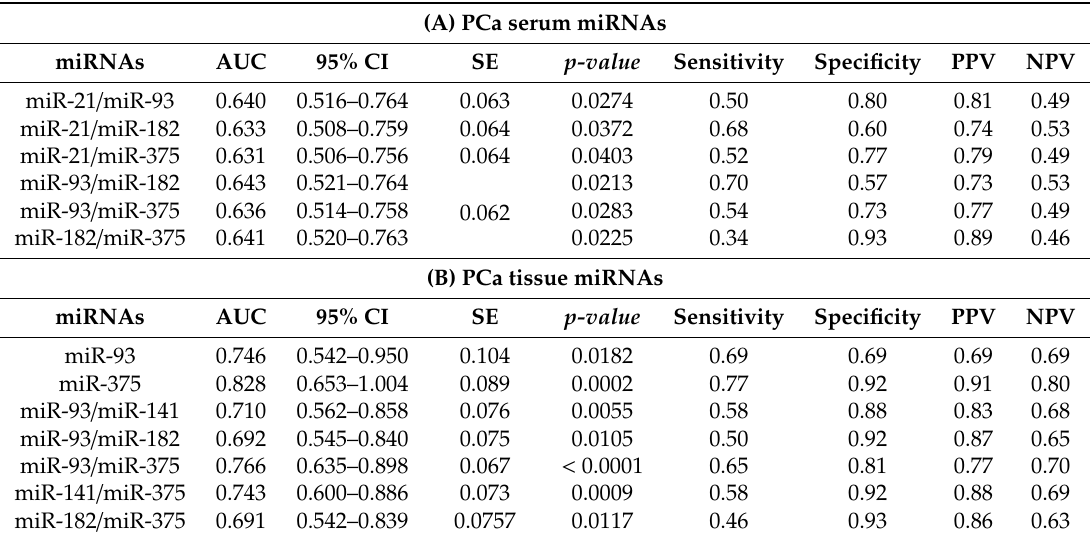
Table 4. miRNAs or combinations of miRNAs from serum ( A , n = 40) and tissue ( B , n = 16) in statistically significant discrimination between aggressive and non-aggressive